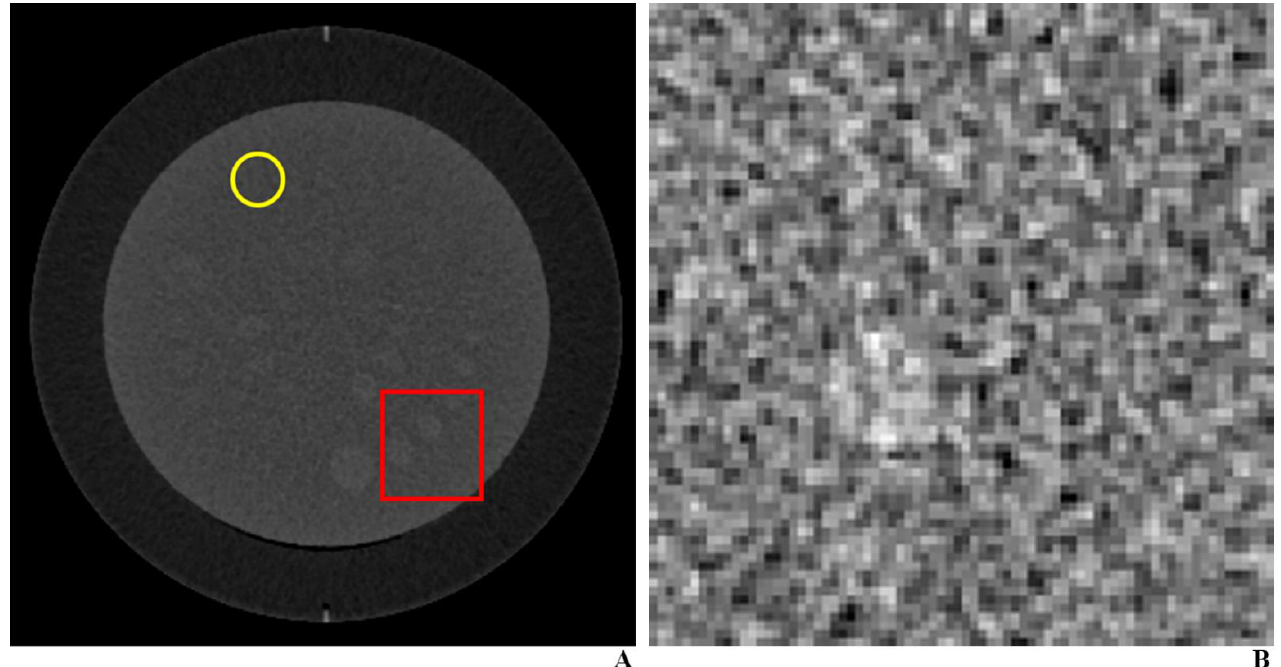
Figure 2. Representative images for the testing set. ( A ). We cropped the images of CT phantom to 5 × 5 cm² size (red box) so that an object of 9-mm or 5-mm size with +10 Hounsfield unit difference would either be absent or present in random locations. We hid unnecessary objects by covering them with object-absent image patches (i.e., a patch of the background as indicated by the yellow circle), leaving only a single object of choice. ( B ). The final image.